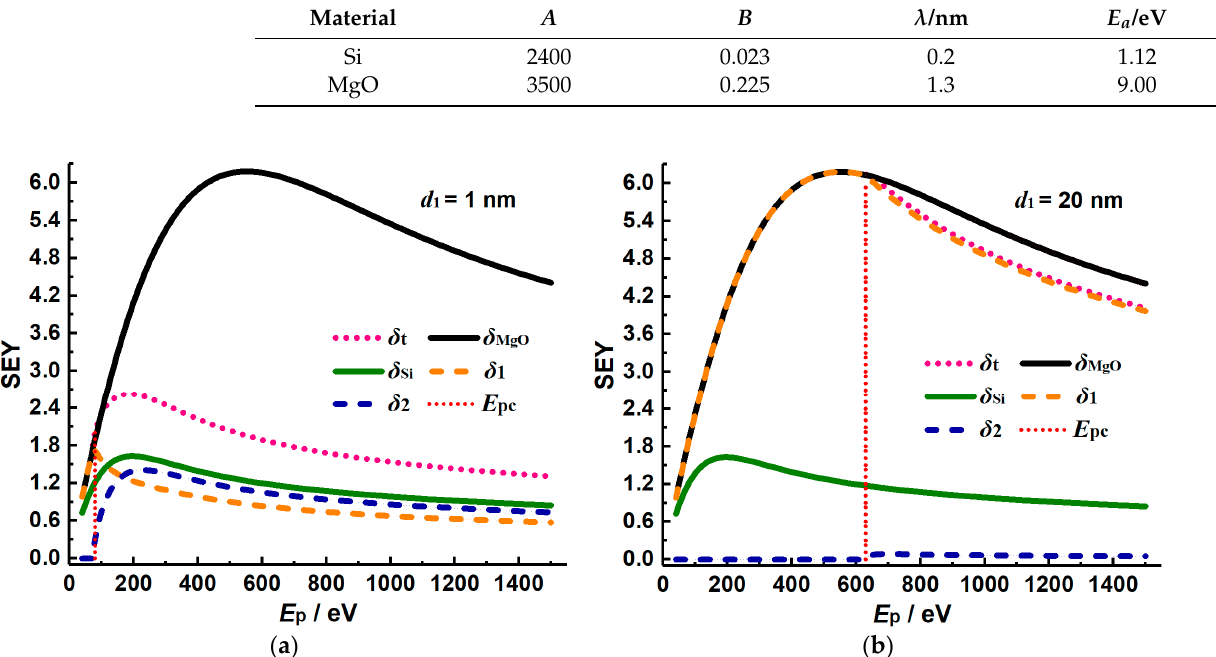
Figure 9. Calculated SEY of MgO/Si double-layer samples for ( a ) d 1 = 1 nm and ( b ) d 1 = 20 nm.